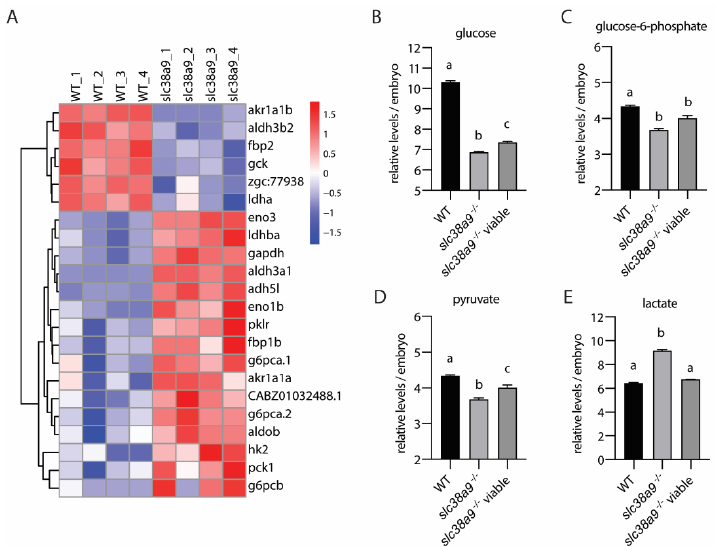
Figure 6. Slc38a9 regulates glycolysis and gluconeogenesis in zebrafish embryos. ( A ) Heatmaps of transcripts in glycolysis and gluconeogenesis enrichment. ( B – E ) Concentrations of glucose ( B ), glu- cose-6-phosphate ( C ), pyruvate ( D ), and lactate ( E ) in WT and slc38a9 mutant zebrafish embryos (60 hpf) measured by LC-MS/MS. Data shown are mean ± SEM, n = 3. Different letters indicate signifi- cant differences at p < 0.05.